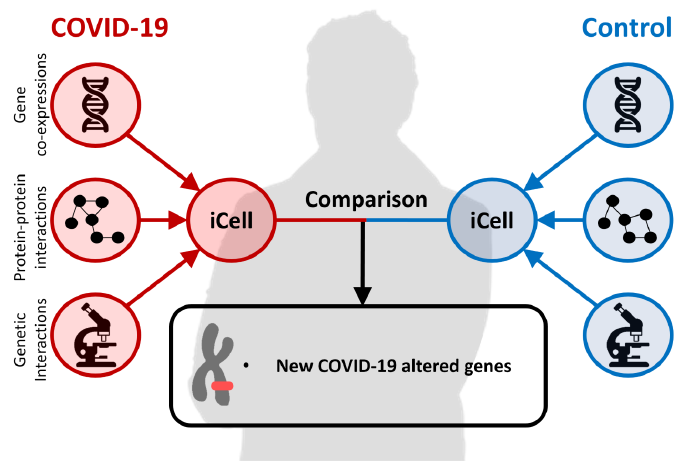
Figure 1. An illustration of the iCell